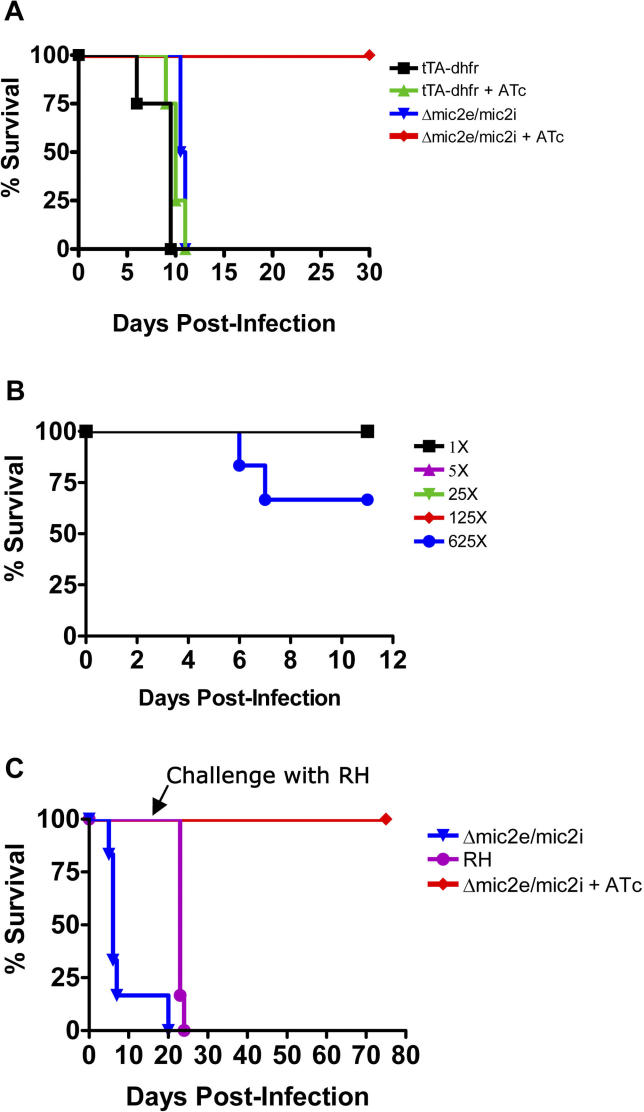
MIC2-Depleted Parasites Are Avirulent in Mice and Confer Protective Immunity to Reinfection(A) 5 × 104 tachyzoites of tTA-dhfr or Δmic2e/mic2i ± ATc were intraperitoneally injected into four BALB/c mice in each group.(B) 5-fold increases in infection dosage with Δmic2e/mic2i +ATc; six mice were infected in each group.(C) Six mice infected with Δmic2e/mic2i + ATc were challenged with 150 tachyzoites of RH at day 16 post-infection. A group of control mice were infected with RH at day 16.